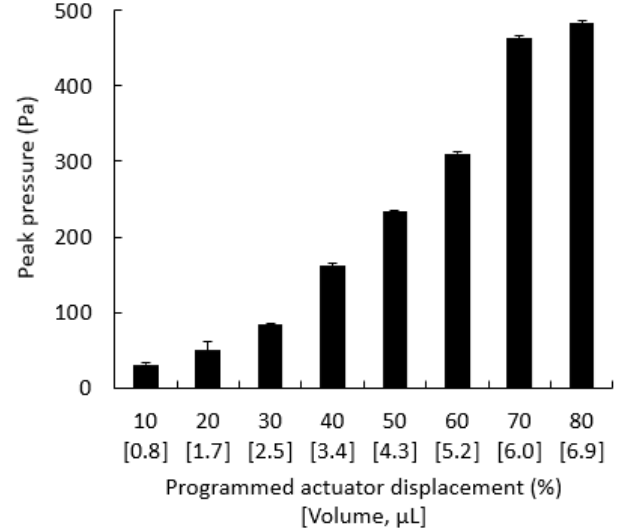
Figure 5. Peak pressure generated by prototypes of the standardized artificial insemination device (SAID) during sample delivery of various volumes. Programmed actuator displacement of 10–80% controlled sample volumes of 0.8–6.9 μ